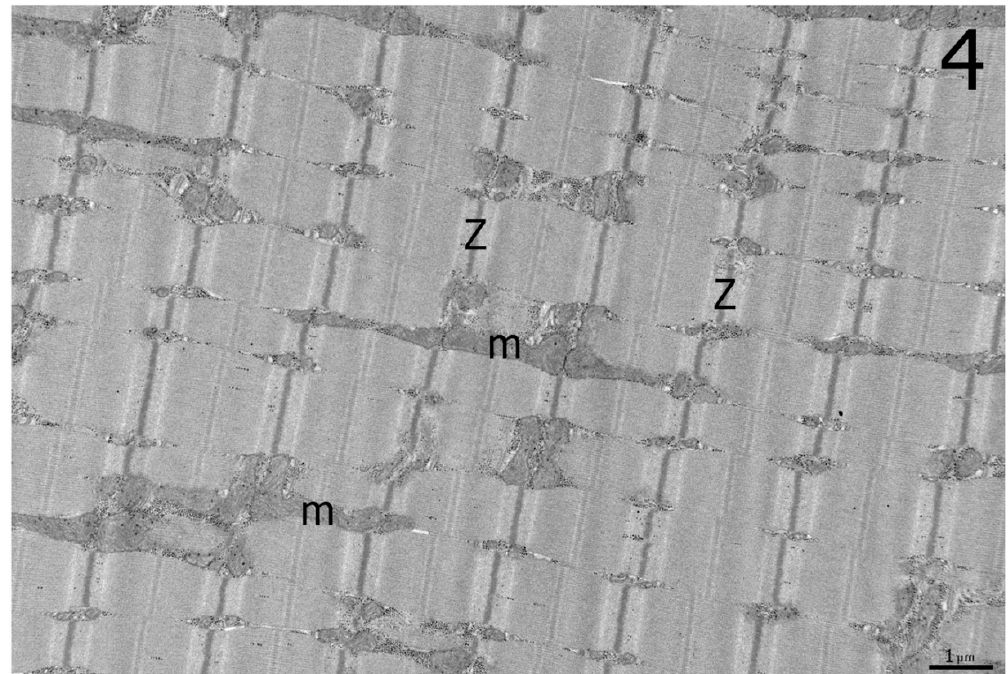
Figure 4. For comparison to Figure 3, an electron micrograph from archived control dog muscle shows variability in the size of mitochondria with the largest mitochondrion spanning 1 sarcomere Z = z line, m = mitochondria.